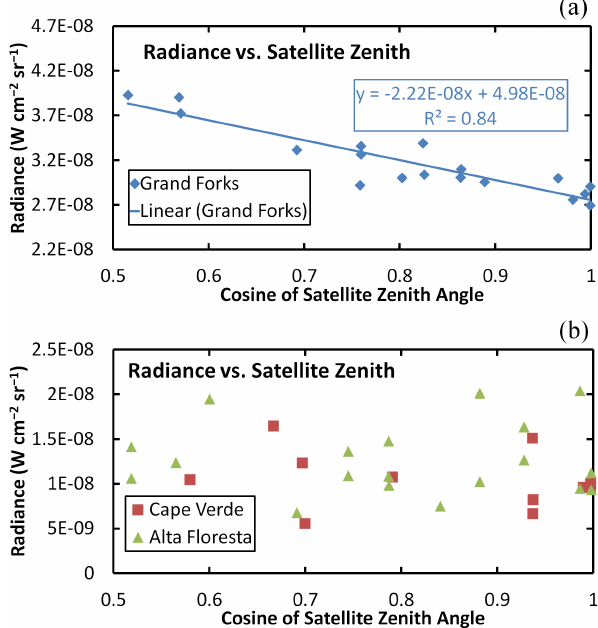
Fig. 3. (a) Radiance versus the cosine of the satellite viewing zenith angle for Grand Forks (blue). (b) Radiance versus the cosine of the satellite viewing zenith angle for Cape Verde (red) and Alta Floresta